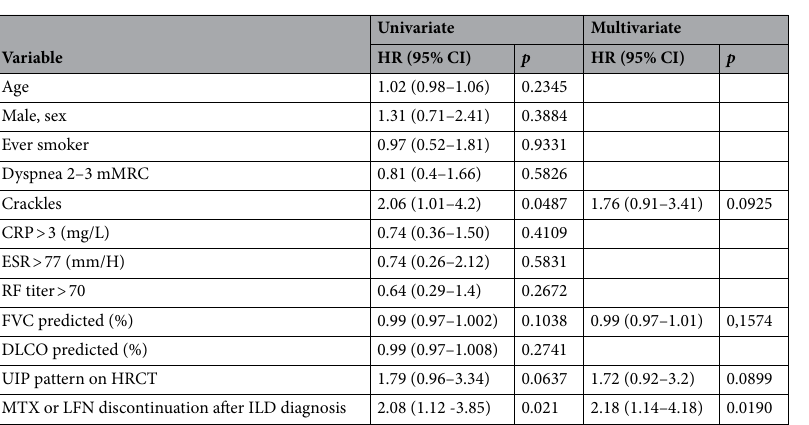
Figure 1. Respiratory functional impairment of the global recruited cases differentiating between groups of progressive and non-progressive patients. FVC (%) impairment is represented in the graph ( a ) and DLCO (%) impairment is represented in the graph ( b ).